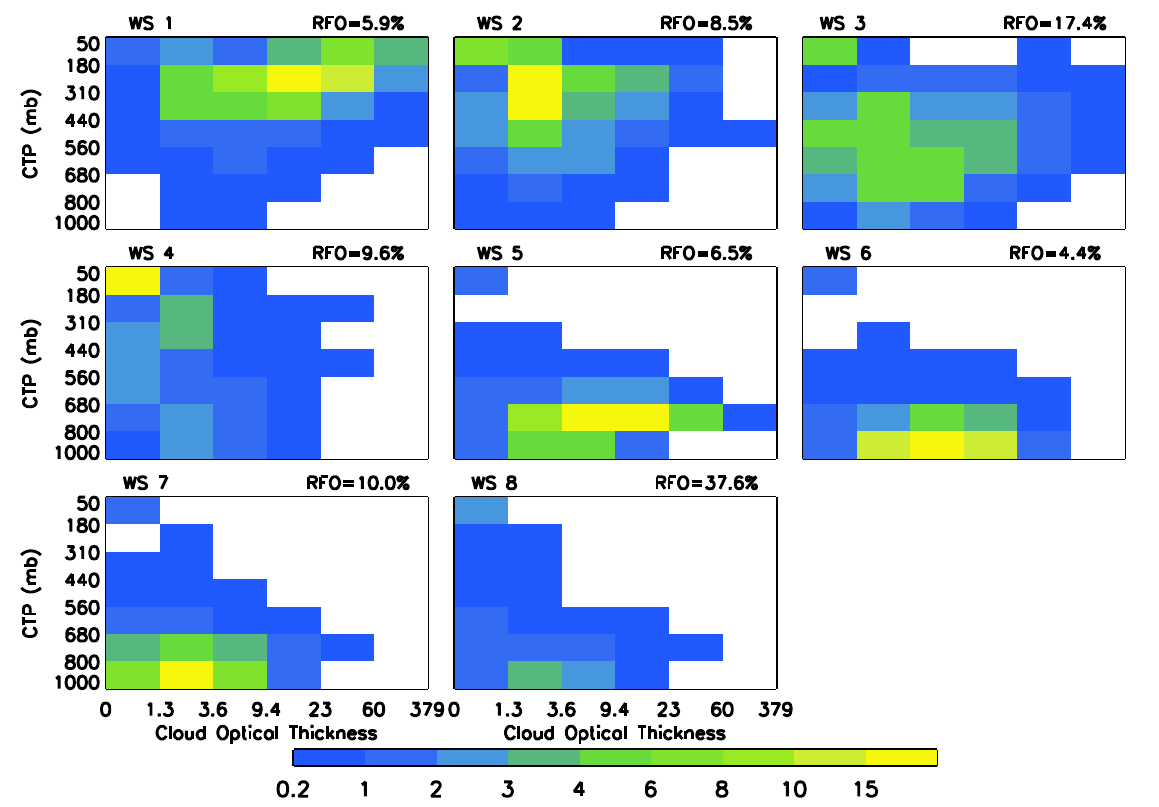
Figure 1. The frequency of occurrence of cloud-top pressure-optical thickness patterns (WSs). The histogram is averaged for global subtropics (±35° latitude) and for the 1983–2004 time period derived from ISCCP D1 data. The WSs 1 to 8 are listed from left to right and top to bottom, where most convective states are in the top row and less convective states are in the middle and bottom rows. The WS relative frequency of occurrence (RFO) over the whole domain is given at the top right corner of each plot. From Mekonnen and Rossow [31].